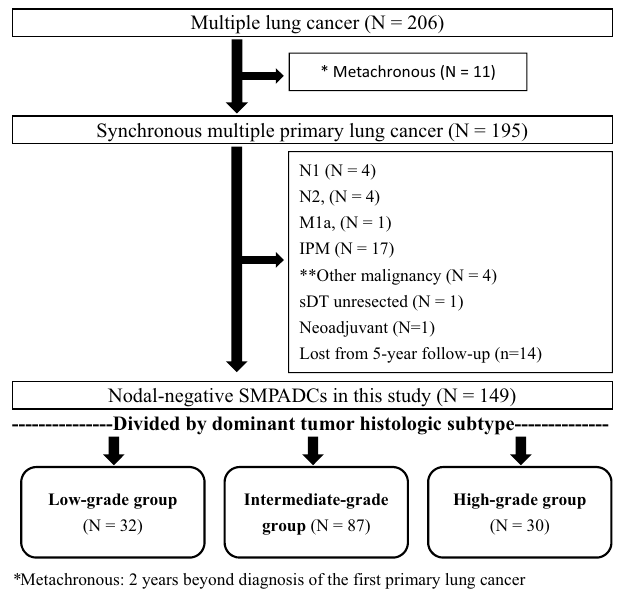
Figure 1. Flow diagram of the selection of patients with synchronous multiple primary adenocarcinomas (SMADCs) included in the present